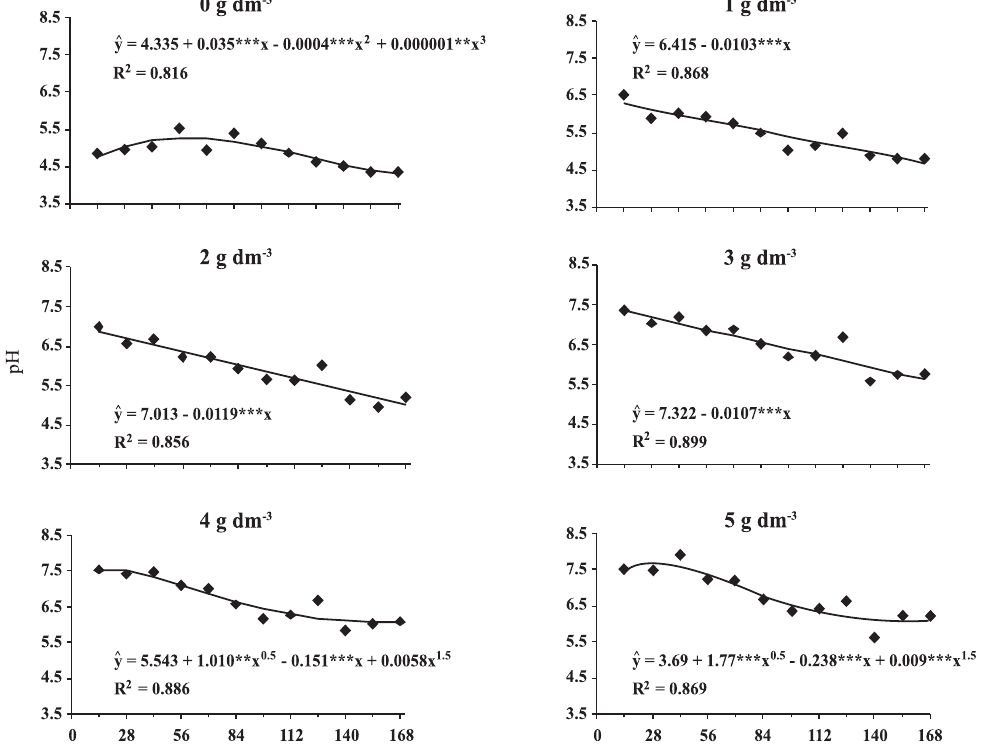
Figure 2. Regression equations of leachate pH as a variable of time and lime rates (0 to 5 g dm -3 ) initially applied to the growth substrate. **,***: significant at 1 and 0.1 %.